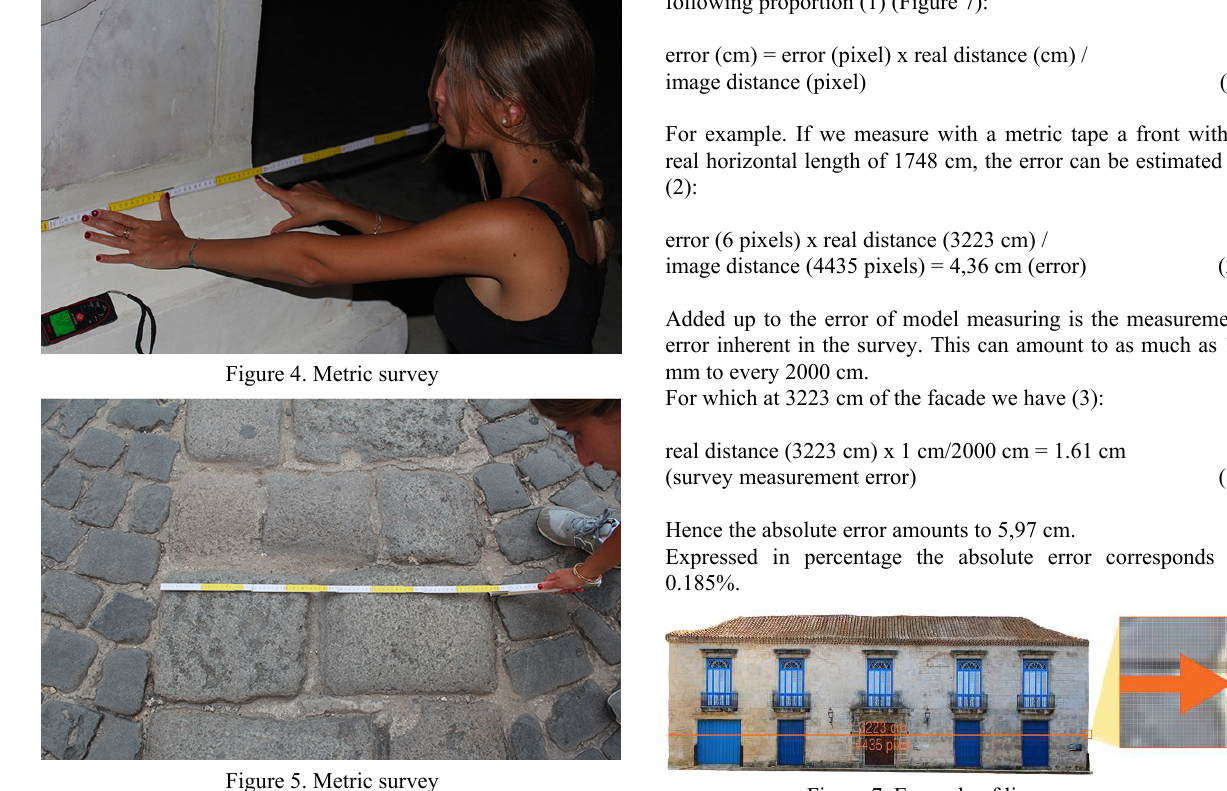
Figure 7. Example of linear